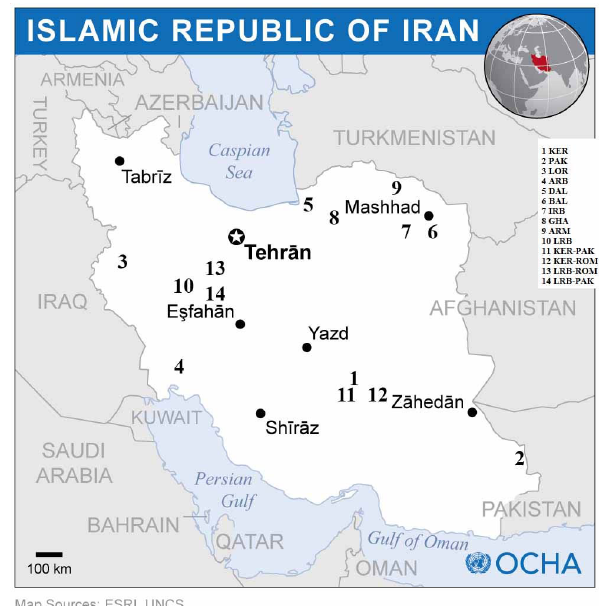
Figure 2. Location of the 14 study sites in Iran. The pu- tative subspecies are indicated as Kermani (KER), Pakistani (PAK), Lori (LOR), Arabi (ARB), Dalagh (DAL),